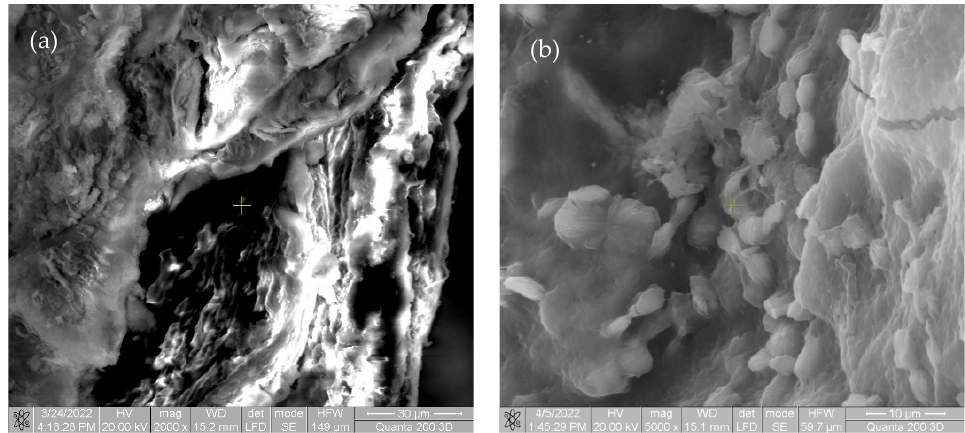
Figure 8. SEM images of rats after four weeks for Mg-0.5Ca-1.5Y ( a ) at magnification of 1000×; ( b ) at magnification of 5000×.